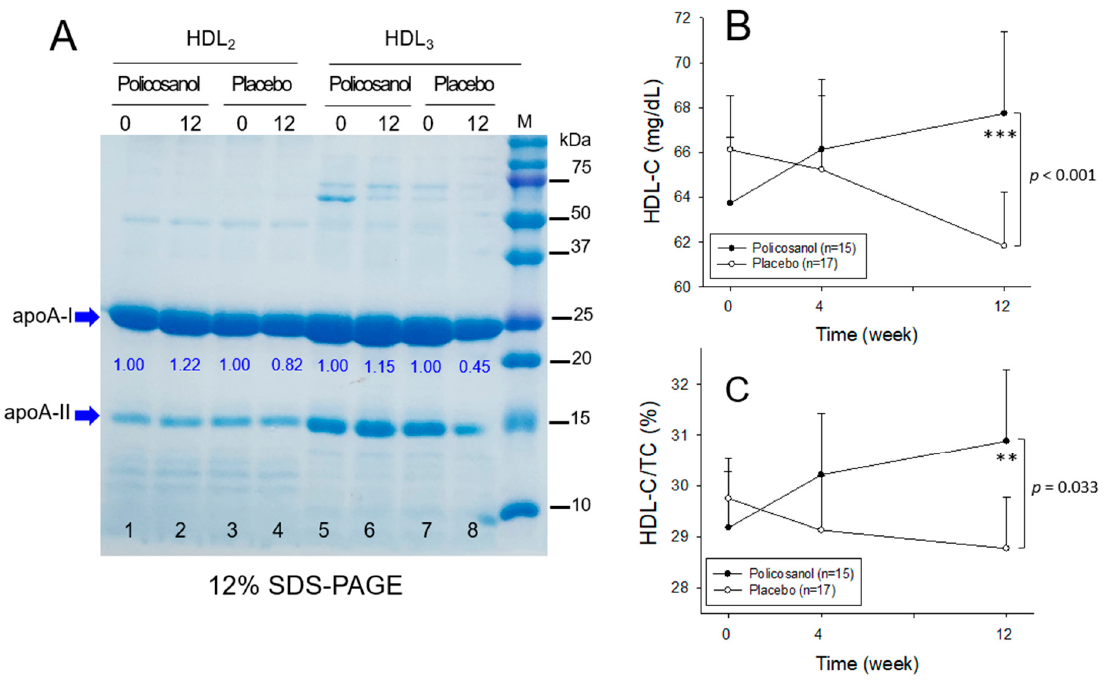
Figure 5. Changes in the apoA-I contents in HDL, HDL-C, and %HDL-C in TC during 12 weeks of consumption of policosanol and placebo. HDL-C, high-density lipoproteins-cholesterol; TC, total cholesterol. ( A ) Electrophoretic patterns of apolipoproteins in HDL in the denatured state from the participants in the policosanol (n = 15) and placebo group (n = 15). The numbers in blue font below the apoA-I band indicate band intensity between weeks 0 and 12. The bands were visualized by 0.125% Coomassie Blue staining and quantified by band scanning using Gel Doc ® XR (Bio-Rad) with Quantity One software (version 4.5.2)) and Image J software (http://rsb.info.nih.gov/ij/, accessed on 29 December 2022) from four gels of the same sample. Lane M, molecular weight standards (Bio- Rad Cat#161-0374). ( B ) Change in the HDL-C (mg/dL) during 12 weeks of consumption of polico- sanol (n = 15) and placebo (n = 17) from repeated measurement ANOVA. The data are expressed as the mean ± SEM. ***, p < 0.001 from the analysis of covariance (ANCOVA) model with the independ- ent variable as the baseline and treatment. ( C ) Change in percentage of HDL-C in TC (%) during 12 weeks of consumption of policosanol (n = 15) and placebo (n = 17) from repeated measurement ANOVA. The data are expressed as the mean ± SEM. **, p < 0.01 from the analysis of covariance (ANCOVA) model with the independent variable as the baseline and treatment. 2.8. Paraoxonase Activities in HDL 2 and HDL 3 As shown in Figure 6, the HDL-associated paraoxonase (PON-1) assay at the same protein concentration (2 mg/mL) showed that the policosanol group at week 12 showed the highest PON-1 activity in both HDL 2 and HDL 3 , approximately 59 and 49 μ U/L/min, while the HDL 2 and HDL 3 at week 0 was approximately 38–42 μ U/L/min. The policosanol group showed a 1.4-fold higher HDL 2 level at week 12 than at week 0 ( p = 0.003), whereas the placebo group showed no change between weeks 0 and 12 (Figure 6A). The policosa- nol group showed a 1.3-fold higher PON-1 level of HDL 3 at week 12 than at week 0 ( p = 0.008), while the placebo group showed no change between weeks 0 and 12 (Figure 6B). These results suggest that policosanol consumption is linked with the specific elevation of the paraoxonase activity in both HDL 2 and HDL 3 .